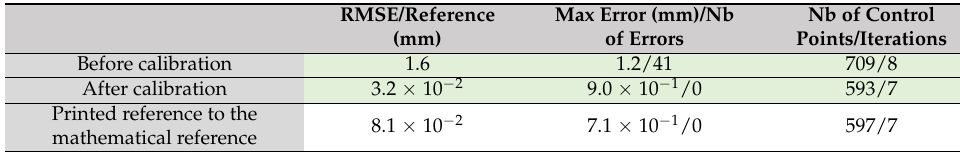
Table 1. Results of the approximation of the printed reference. The results of the approximation of the scanned printed surface before and after the calibration.